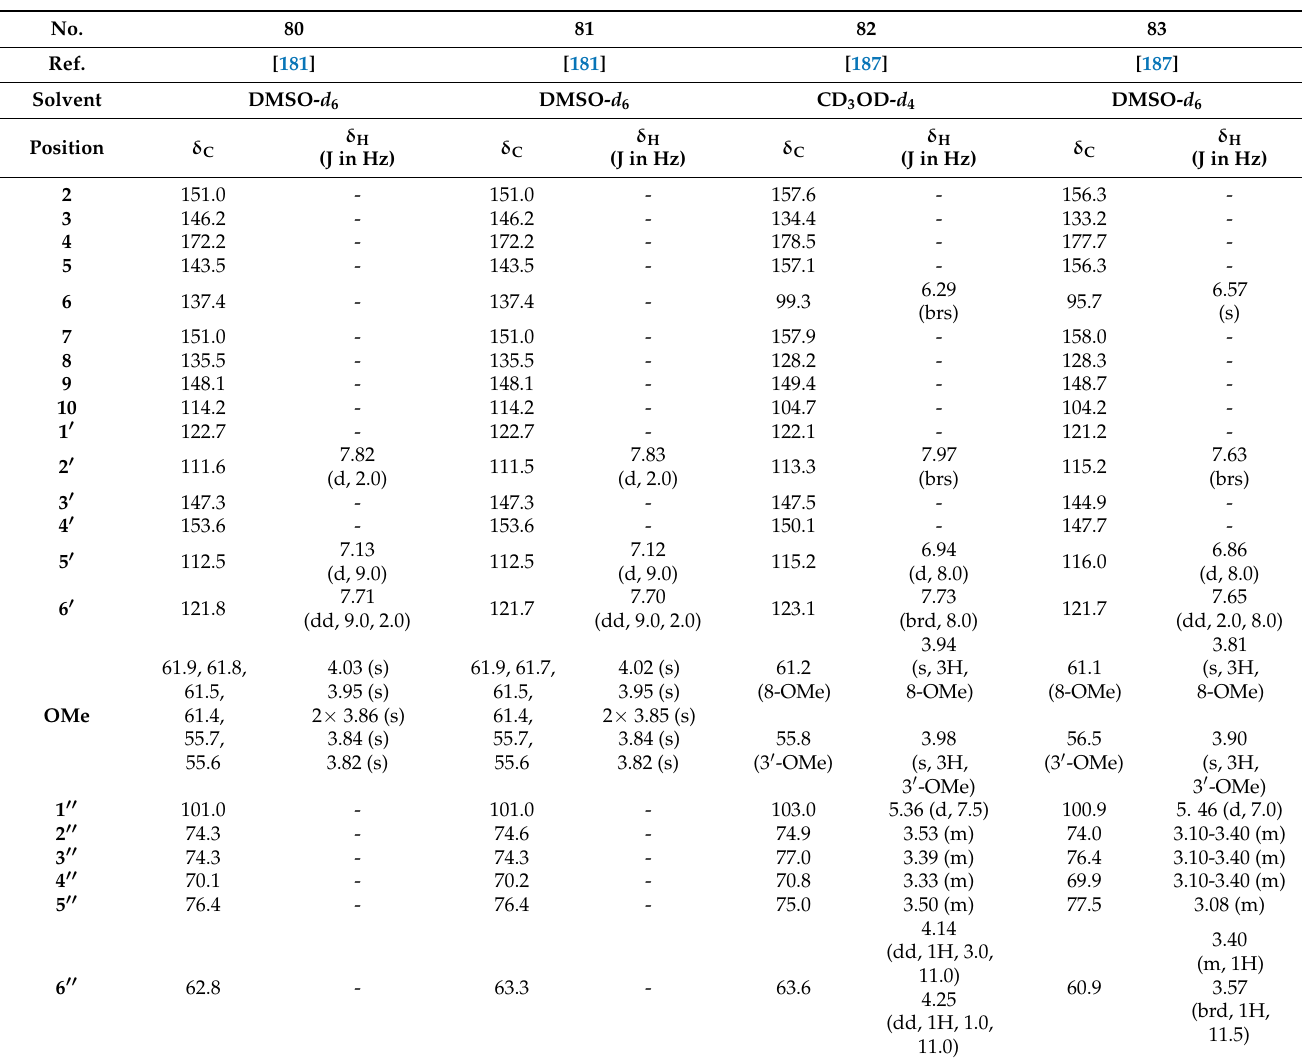
Figure 5. Glycosylated flavones ( 80 – 91 ) from Citrus trees. Table 16. Glycosylated flavones ( 80 – 83 ) extracted from Citrus genus .